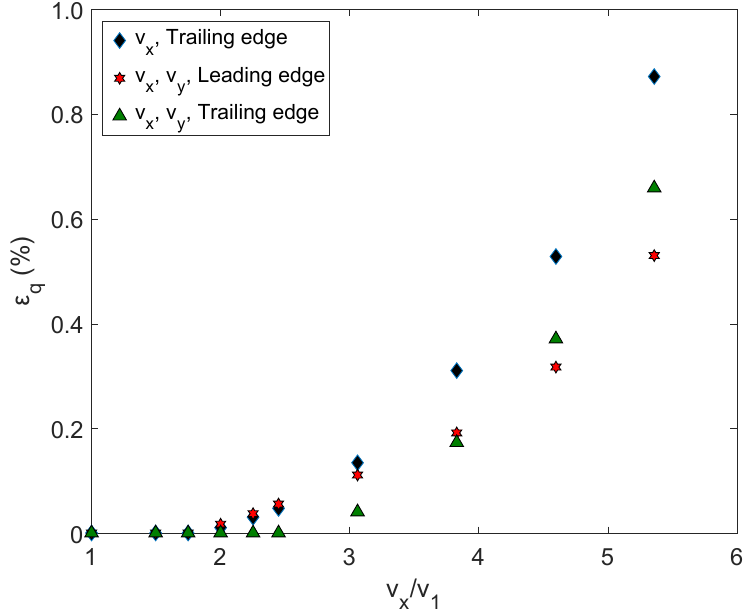
Figure 13. Equivalent plastic strain of the blade, for the different velocities of the killer whale at x -direction, considering one-directional and two-directional velocity of the sea animal; v y = 1 m/s for each